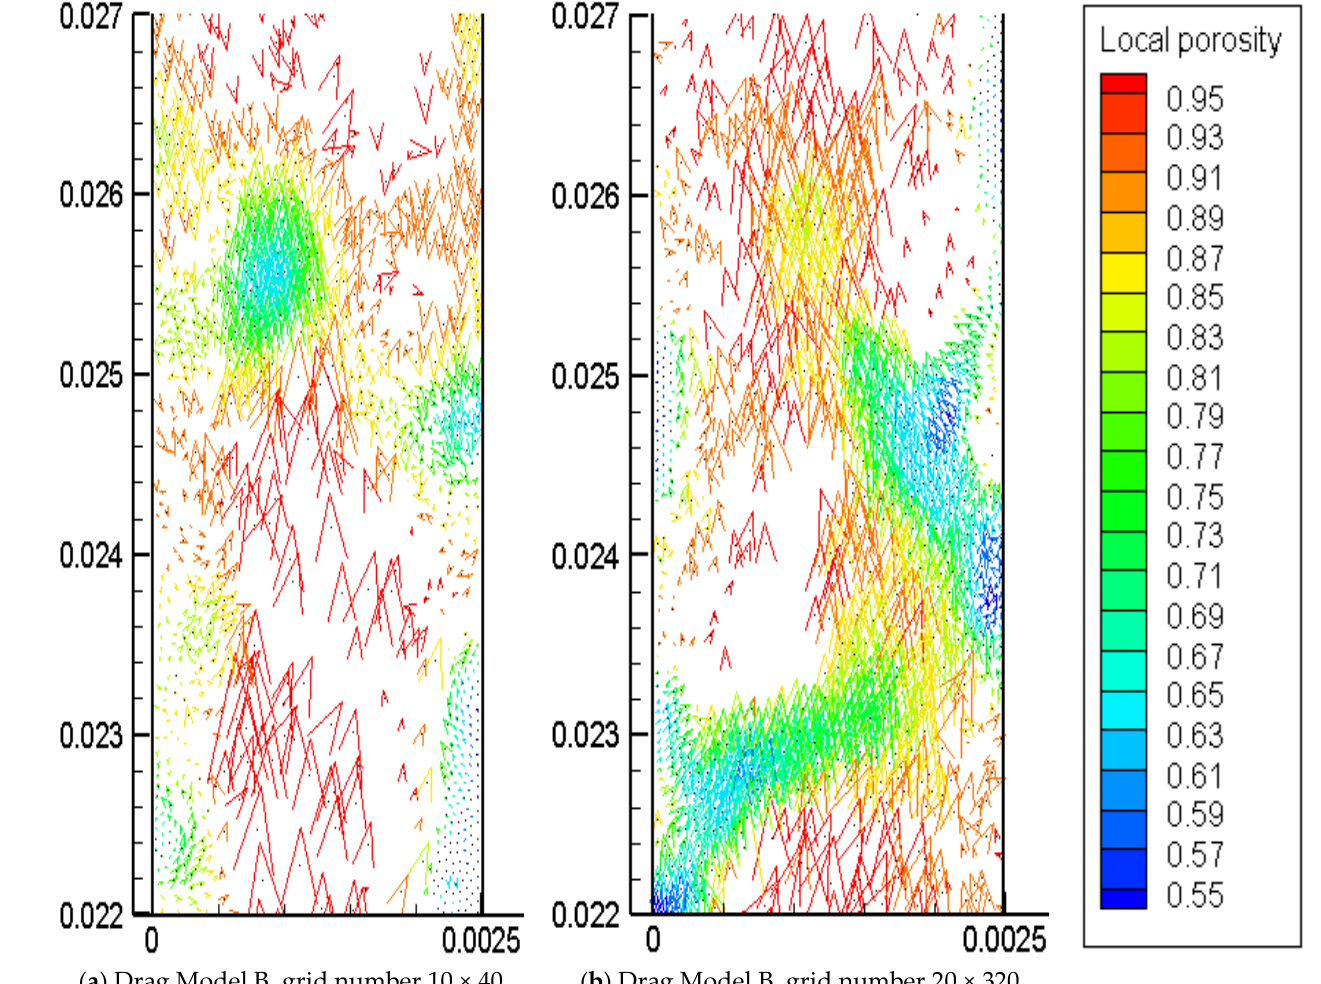
Figure 6. Sectional particle velocity and local porosity distributions.